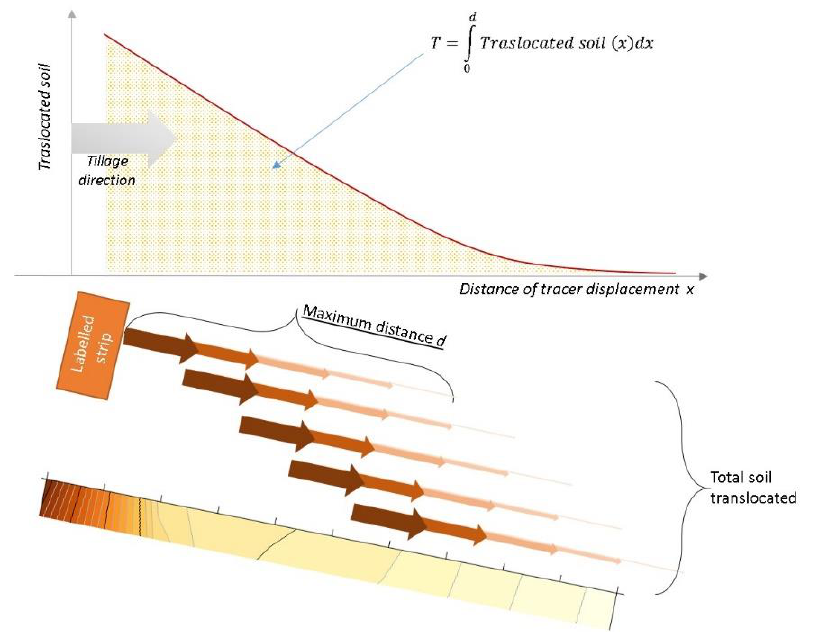
Figure 2. Graphical representation of the estimation method of the total translocated soil.